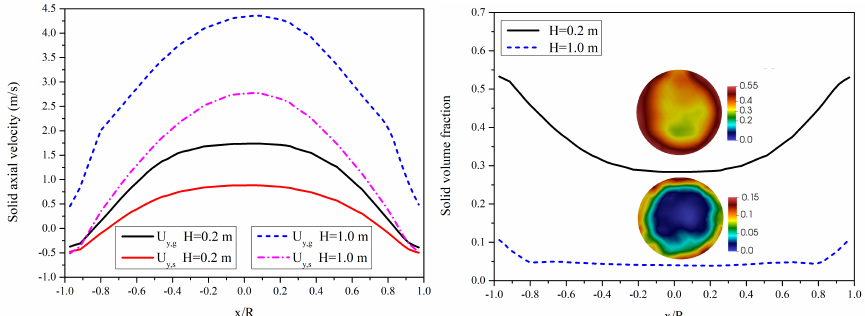
Figure 11. Left : The distribution of time-averaged axial velocity of gas and solid phases. Right : The distribution of time-averaged solid volume